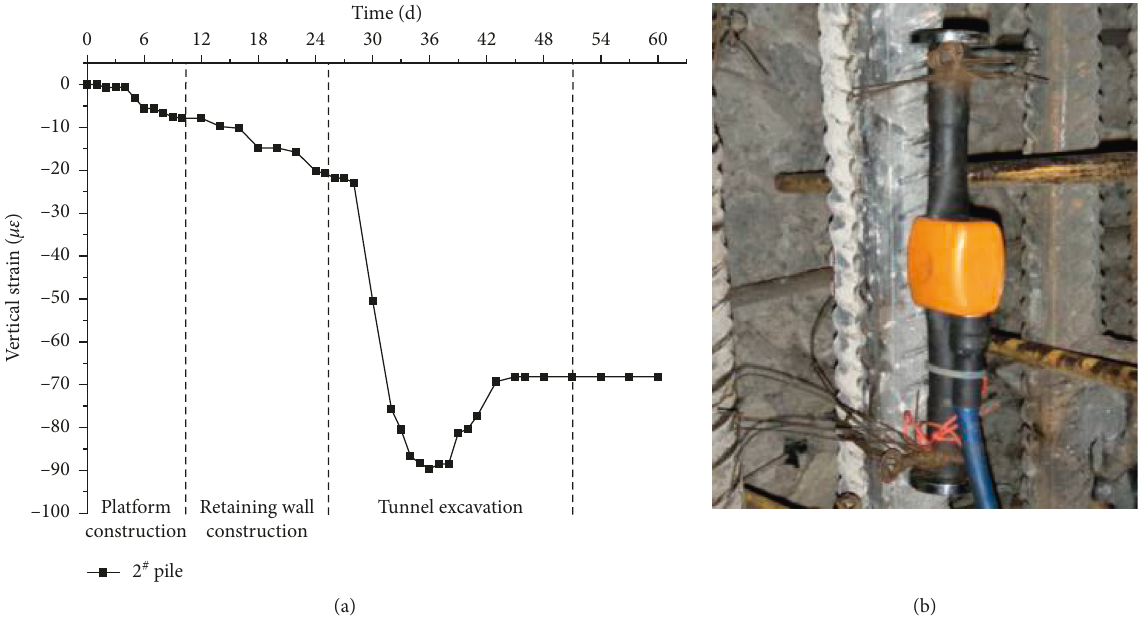
Figure 14: Strain test of the pile. (a) Vertical strain of no. 2 pile top. (b) Site installation.